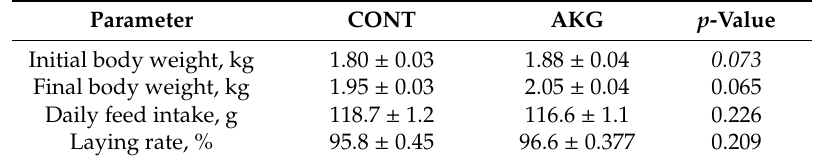
Table 2. The influence of alpha-ketoglutarate (AKG) supplementation on daily feed intake during the experimental period, 31–60 weeks of age, and bodyweight of laying hens at the age of 60 weeks.